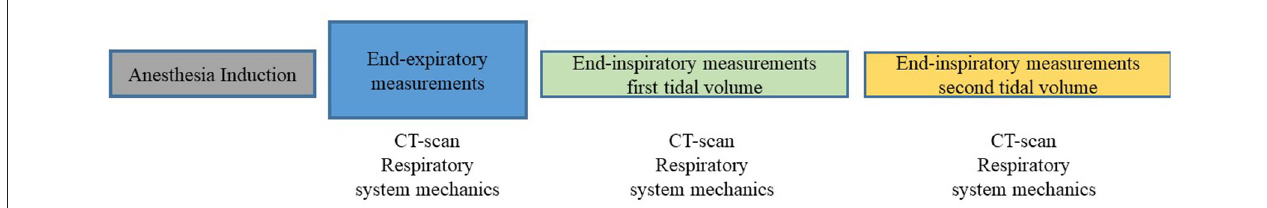
FIGURE 1 | Flowchart illustrating the experimental design. After induction of anesthesia, six obese dogs undergoing computed tomography (CT) scans were ventilated with a tidal volume of 15ml kg − 1 of current (VTc) and ideal (VTi) body weight, applied in random order. On each experiment, end-expiratory CT scans and respiratory system mechanics were recorded once. At the end of each study treatment (VTc and VTi) end-inspiratory CT images, respiratory system mechanics and arterial blood gases were